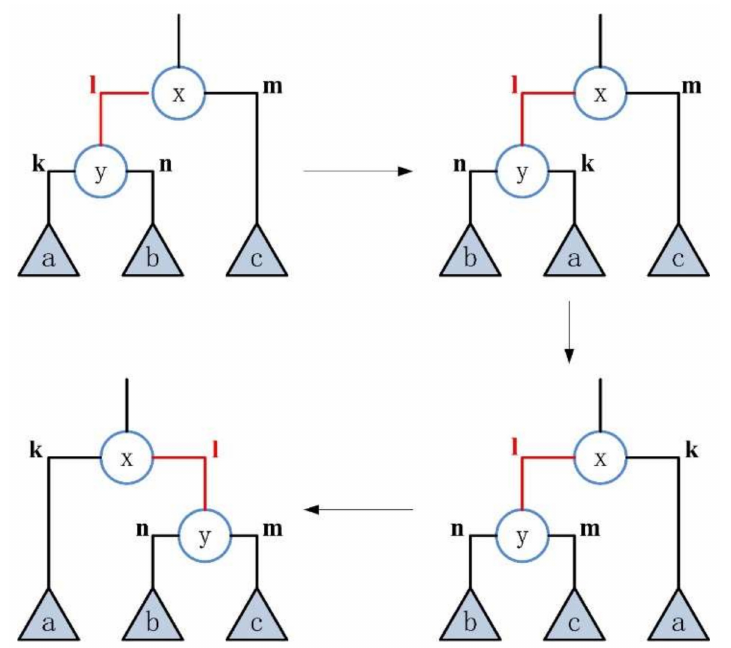
Figure 4. The β transformation of the inner edge of type “left”.